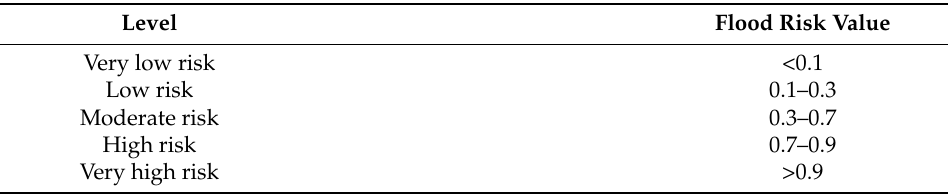
Figure 12. Sensitivity analysis results: ( a ) H 1 , ( b ) E 2 , ( c ) E 3 , ( d ) E 4 , ( e ) V 4 . R1 = Very low risk, R2 = Low risk, R3 = Moderate risk, R4 = High risk, R5 = Very high risk. Table 9. The definitions of flood